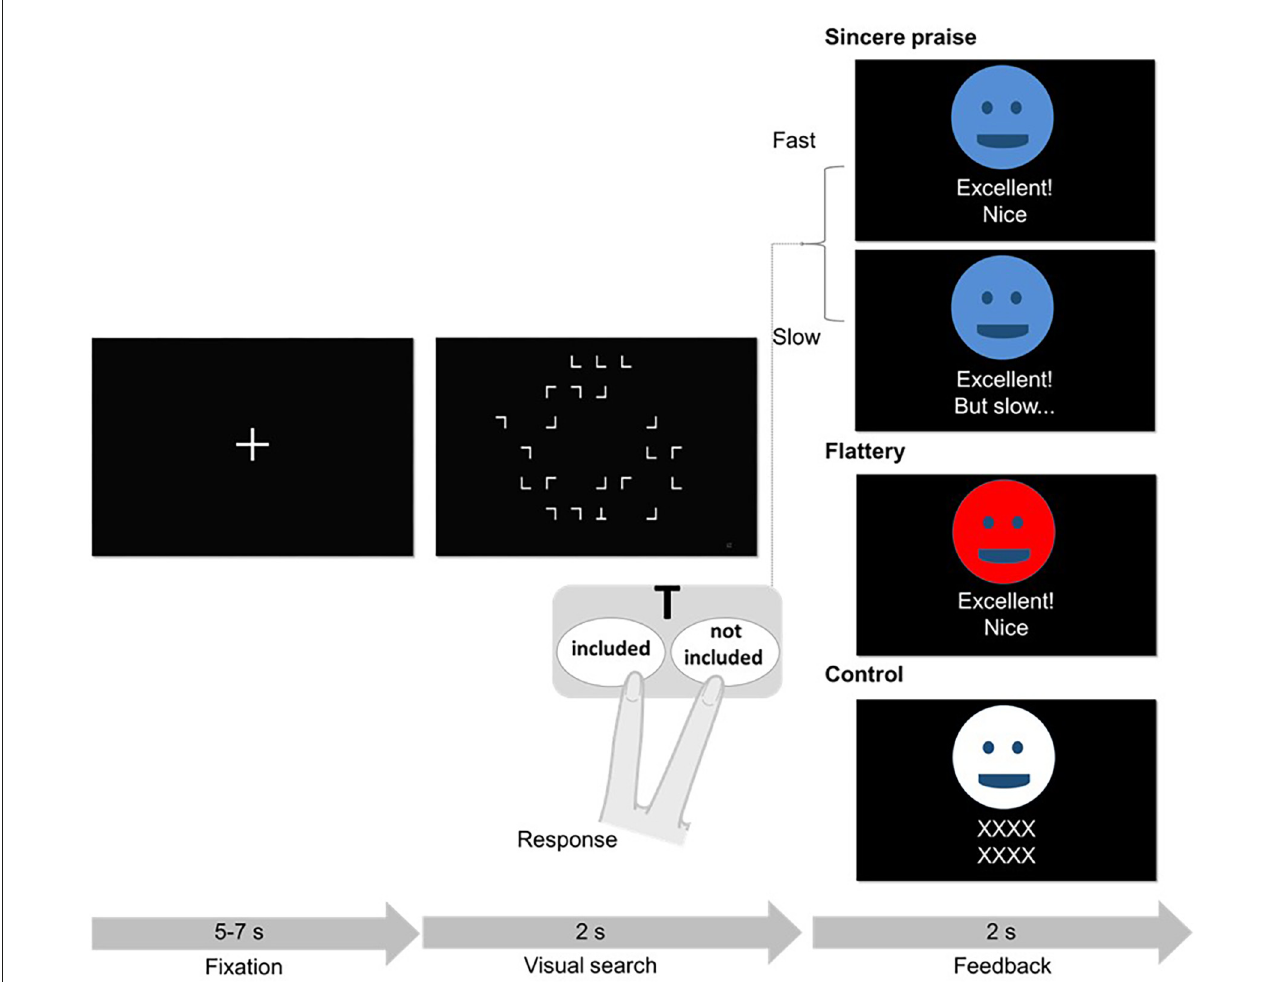
FIGURE1 Schematic of the visual search trial and feedback. One of the three face avatars provided feedback following each trial. The association between color (blue, red, or white) and feedback condition (sincere, flattery, or control) was randomized across participants. In the sincere praise condition, different feedbackwasprovideddependingontheparticipant’sreactiontime(fastorslow).Intheflatterycondition,participantsalwaysreceivedthesamefeedback. In the control condition, a string of “X”s was presented. Although not shown here, colored face avatars provided feedback on mistakes in the sincere praise (“Oh my, incorrect”), flattery (“Excellent! Nice”), and control (“XXXX XXXX”) conditions. If a response was not received in time, a face avatar presented the words “Time up (no